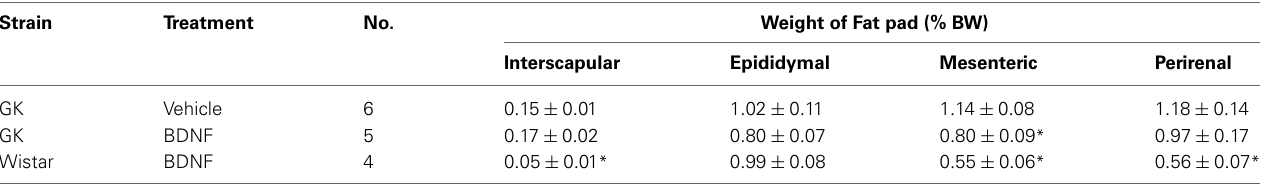
Table 2 | Effect of BDNF on interscapular, epidiymal, mesenteric and perirenal fat weights (% body weight) in GK rats. Strain Treatment No.